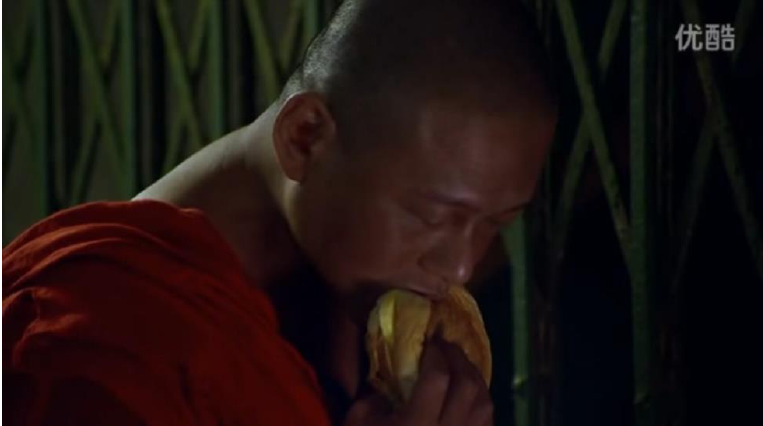
Figure 10. Mindful eating.